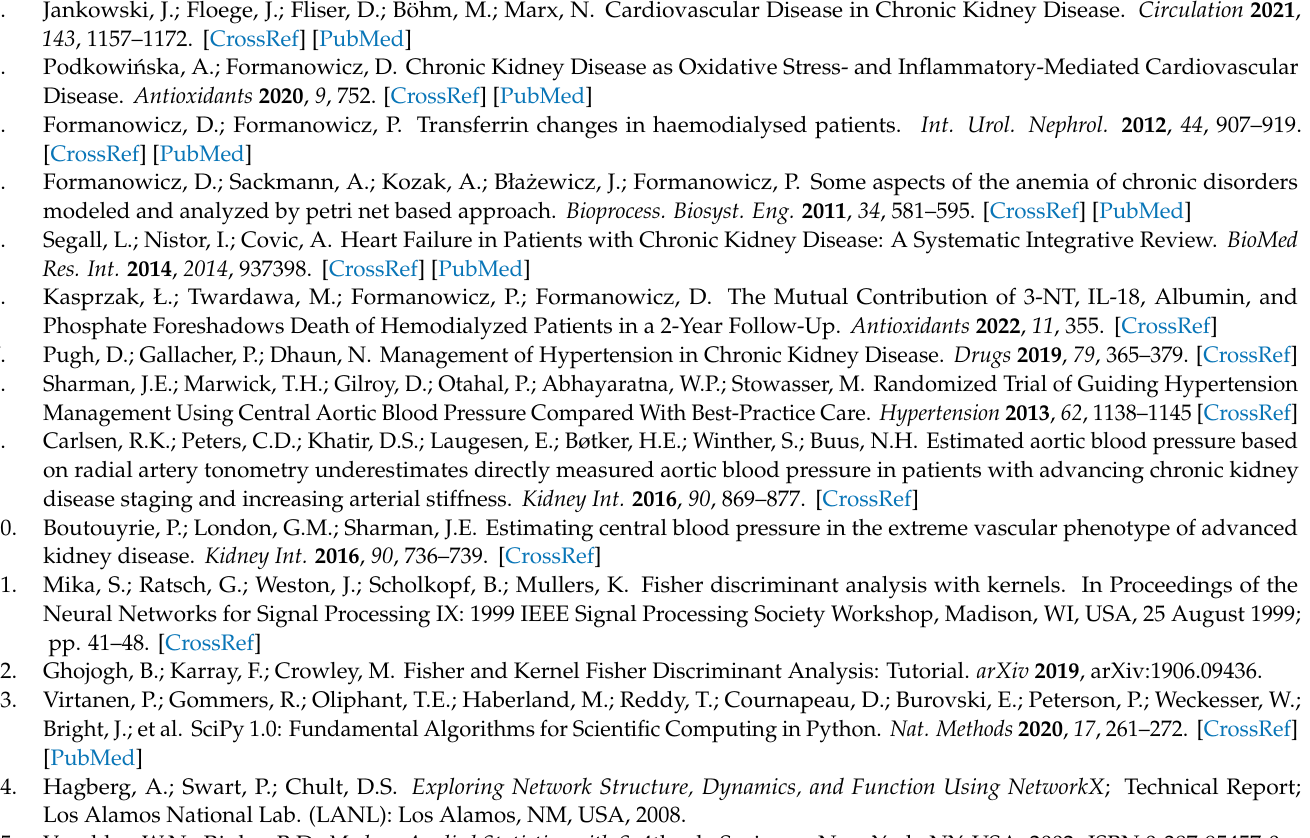
PRE group; Figure S12: Correlation heatmap for all possible pairs of tonometric parameters within the CARD group; Figure S13: Correlation heatmap for all possible pairs of tonometric parameters within the CKD1-2 group; Table S1: Wald test results for the chosen combination of tonometry variables in the multinomial logistic regression model; Table S2: Comparison of different available kernels for KFDA algorithm; Table S3: Group specific descriptive statisctis calculated for tonometry parameters and general biometric data; Table S4: Full Spearman cross correlation results for each group; Table S5: Exact number of patients within each group with additional number of deceased within 2 years